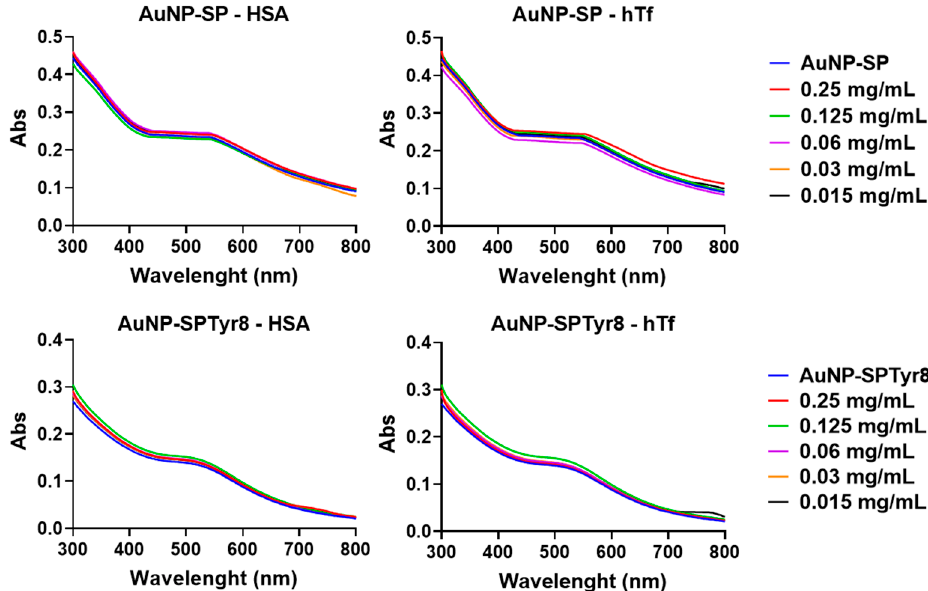
Figure 3. UV-vis spectra of AuNP-SP and AuNP-SPTyr8-([AuNP] = 0.1 mg/mL) exposed to different concentrations of HSA and hTf proteins.